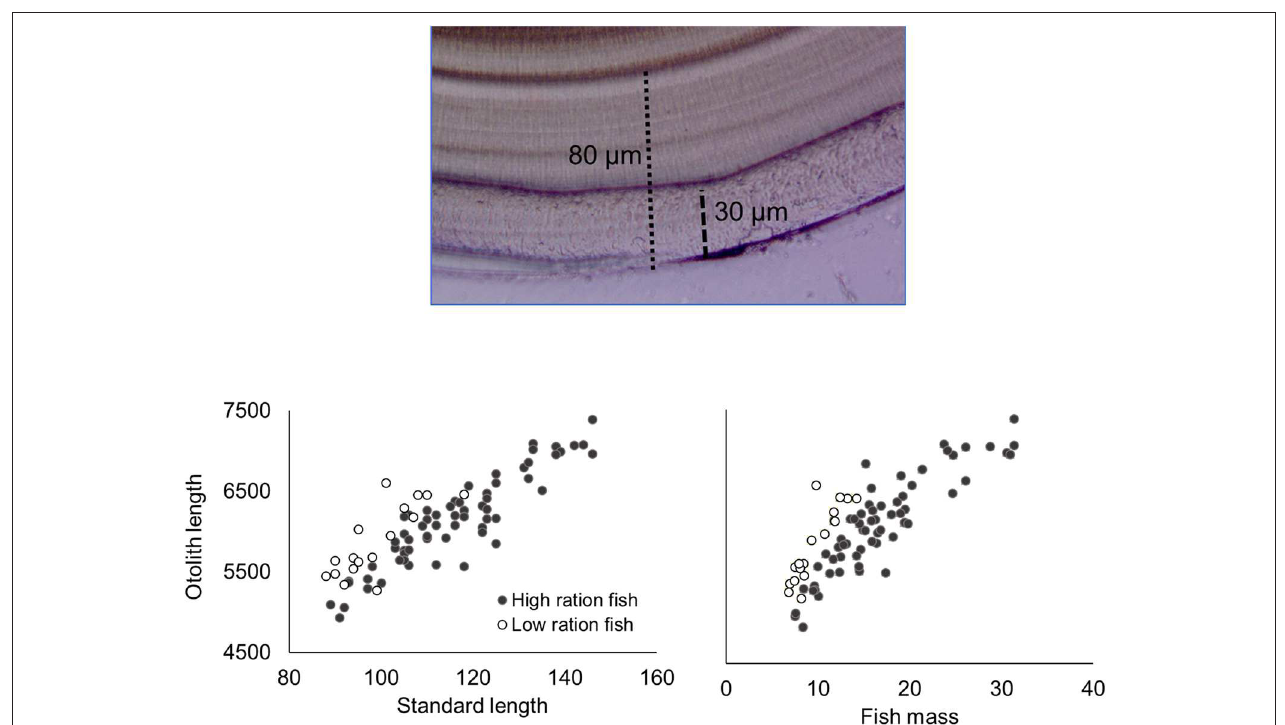
FIGURE 1 | Image of otolith from the low-ration treatment (top image) with apparent stress check (at 80 µ m) and ablation scar (30 µ m) indicated. Otolith length plotted against fish standard length (left graph) and fish mass (right graph) at the end of the experiment are also included, with the low- and high-ration fish